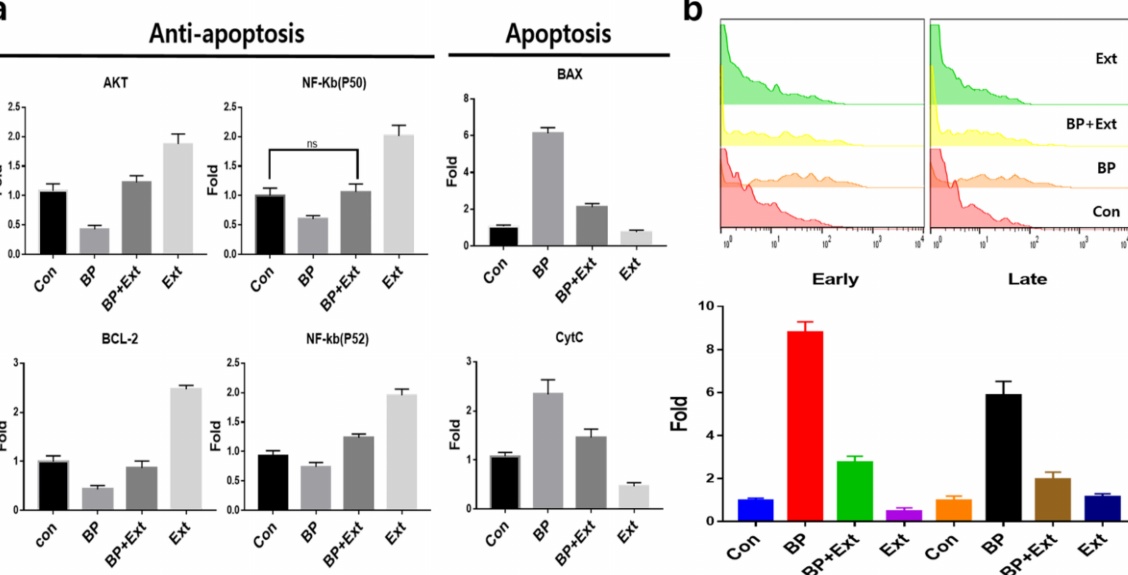
Figure 3. Expression levels for anti-apoptotic and apoptotic markers in fibroblast cells exposed to black jade extract. ( a ) The bar graphs indicating relative fold changes for the markers. ( b ) Histograms for the cellular viability under benzo(a)pyrene (BP) or the black jade extract (Ext). BP+Ext represents that fibroblast cells were exposed to BP after treatment using Ext. Con; control, ( p < 0.05, n =